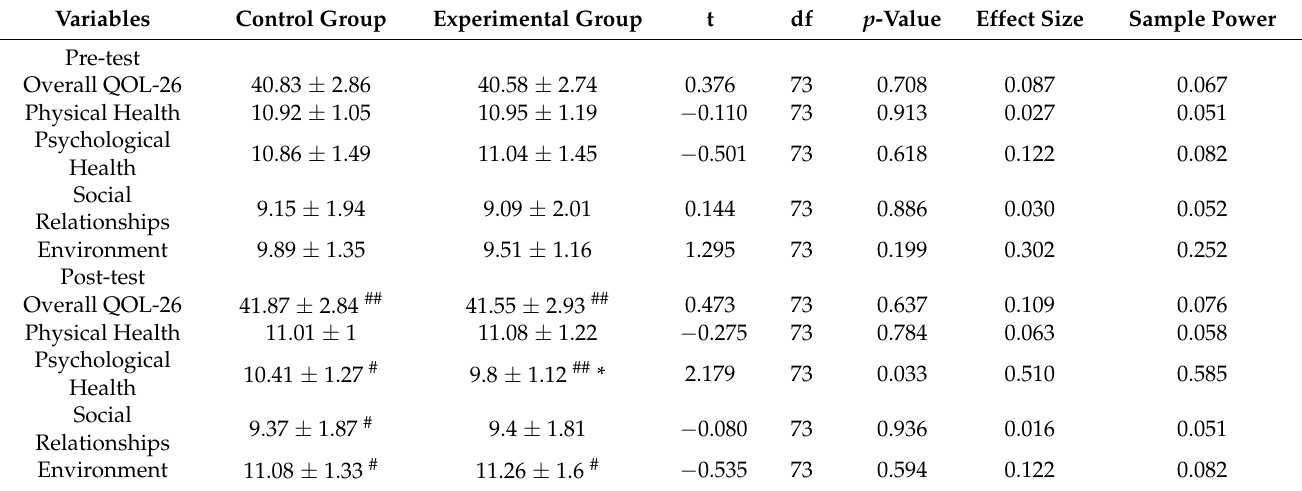
Table 10. Between-group comparison for WHOQOL-26 across two intervals.